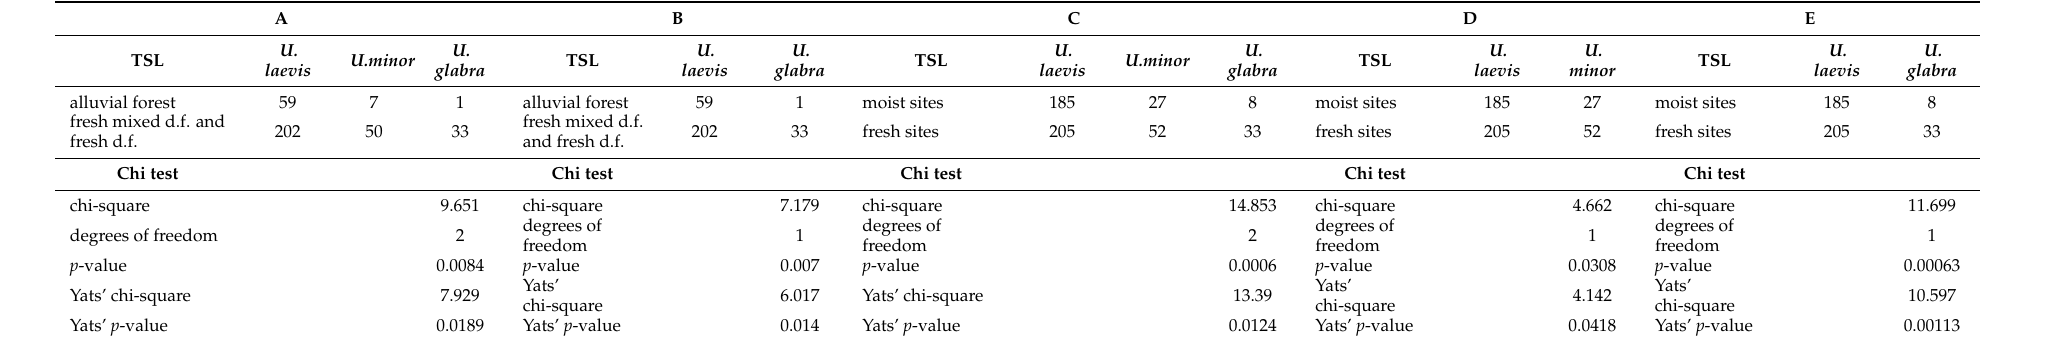
Table 7. Distributions of partial data from Table 6, which differ statistically significantly. A—localities from alluvial and ‘oak-hornbeam’ (fresh mixed d.f. and fresh d.f.) sites only; B—localities from alluvial and ‘oak-hornbeam’ (fresh mixed d.f. and fresh d.f.) sites and localities of U. laevis and U. glabra only; C—sums of localities from moist and fresh sites; D—sums of localities from moist and fresh sites, localities of U. laevis and U. minor only; E—sums of localities from moist and fresh sites, localities of U. laevis and U. glabra